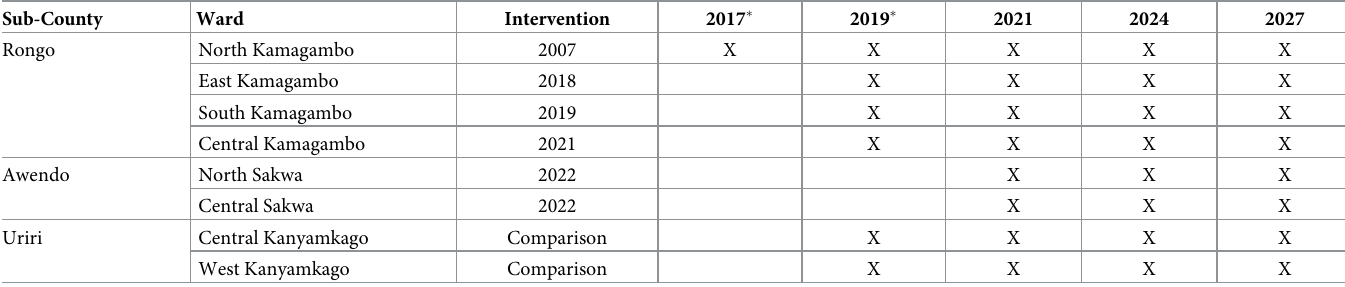
Table 1. Survey timepoints across